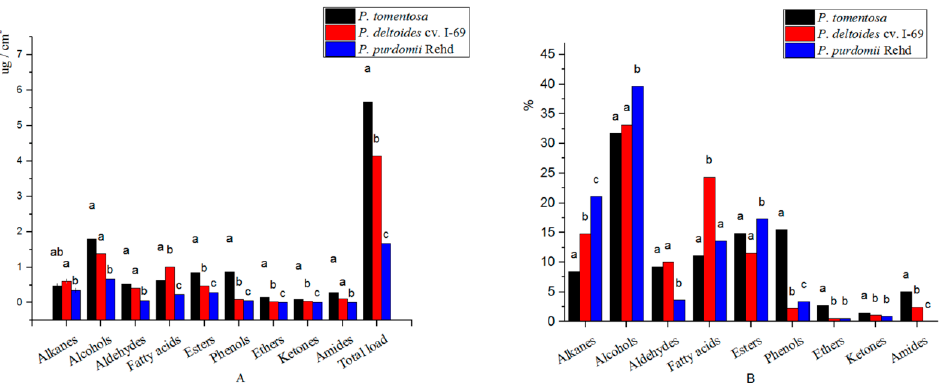
Figure 2. Absolute ( A ) and relative ( B ) quantities of cuticular compounds in Populus purdomii , Populus deltoides and Populus tomentosa susceptible hosts, resistant hosts and non-hosts, respectively, to M. larici-populina . Note: ‘Absolute content’ is the total quantity ( µ g) per unit square centimeter of leaf. The ‘relative content’ is the ratio of each cuticle component divided by the total cuticle content. Error bars are standard errors of the means. Significance at p < 0.05 is indicated by different letters above bars (Duncan’s multiple range test).